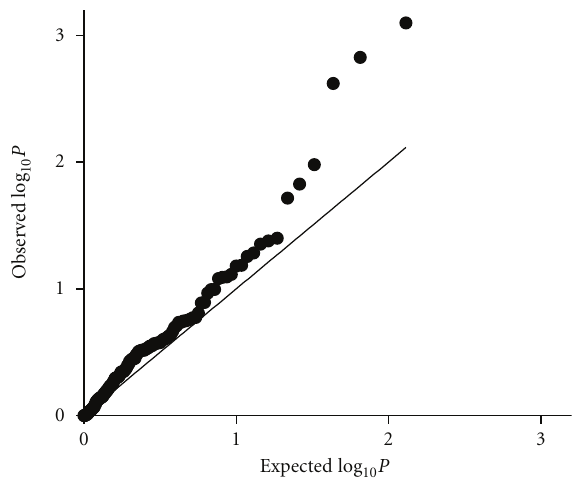
Figure 2: Q-Q plot showing the observed versus expected P values in the autoantibody analysis. P values that would be expected under the null hypothesis (no association between SNPs and autoantibody traits) are represented by the line, and the observed P values are represented by dots, one for each tested SNP-autoantibody